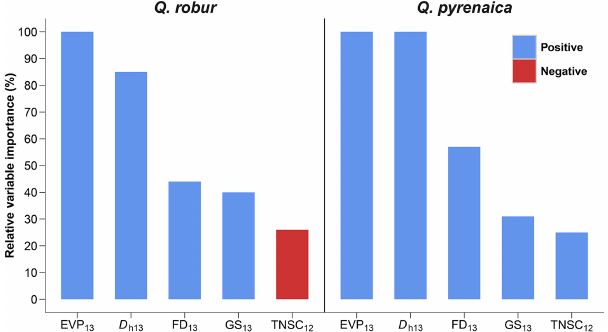
Figure 7. Relative importance of the variables driving latewood production in 2013, expressed as a percentage, for Quercus robur ( N = 120) and Q. pyrenaica ( N = 120). Site effect was included as a random factor in the model. NSC 12 are total non-structural car- bohydrates in December 2012, D h13 is hydraulic diameter in 2013, EVP 13 is earlywood vessel production in 2013, GS 13 is length of the growing season in 2013, and FD 13 is foliage density in 2013. Different colours of bars denote variables with either a positive or negative